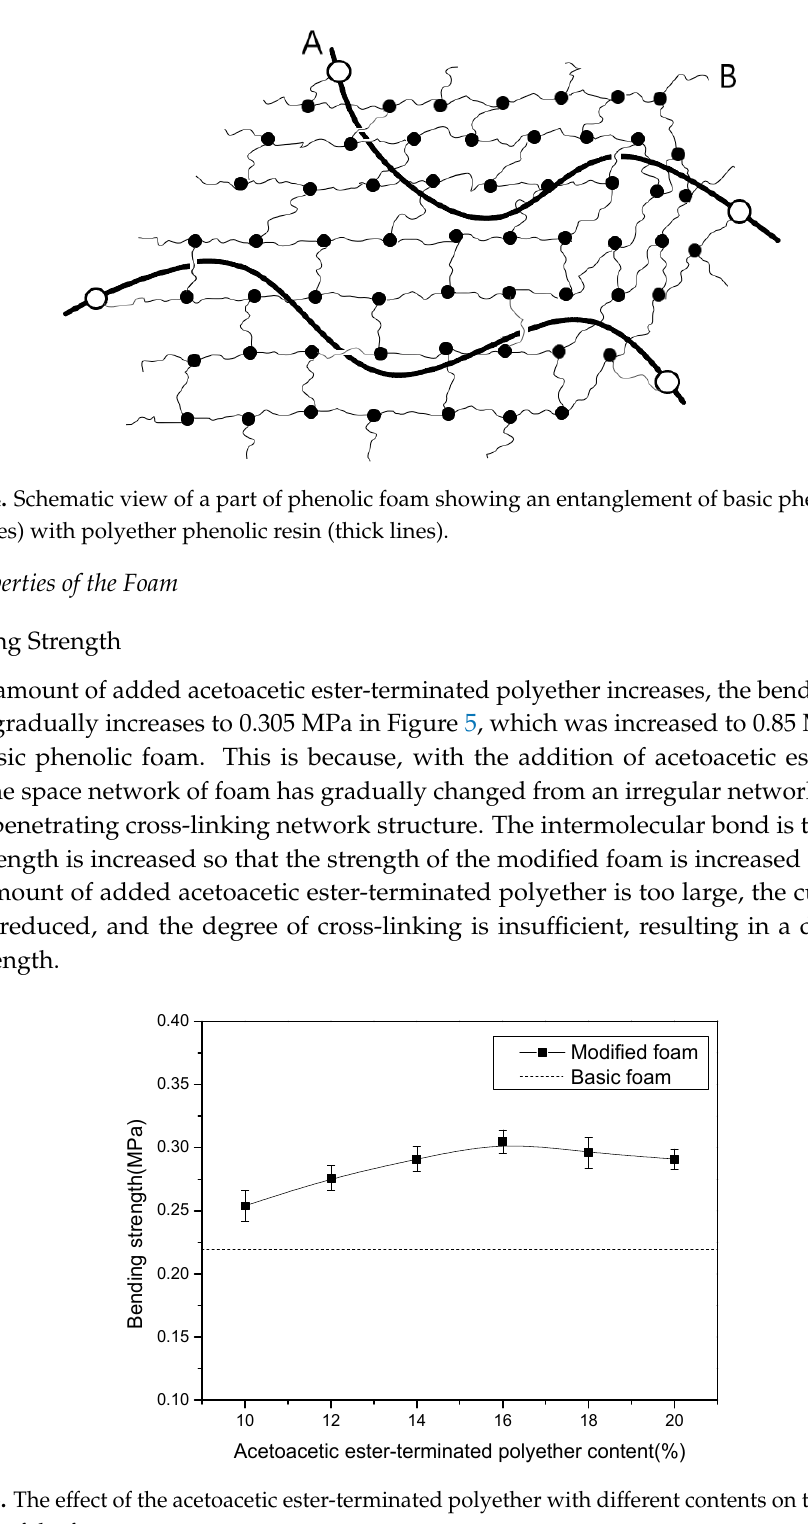
Figure 5. The effect of the acetoacetic ester-terminated polyether with different contents on the bending strength of the foam.